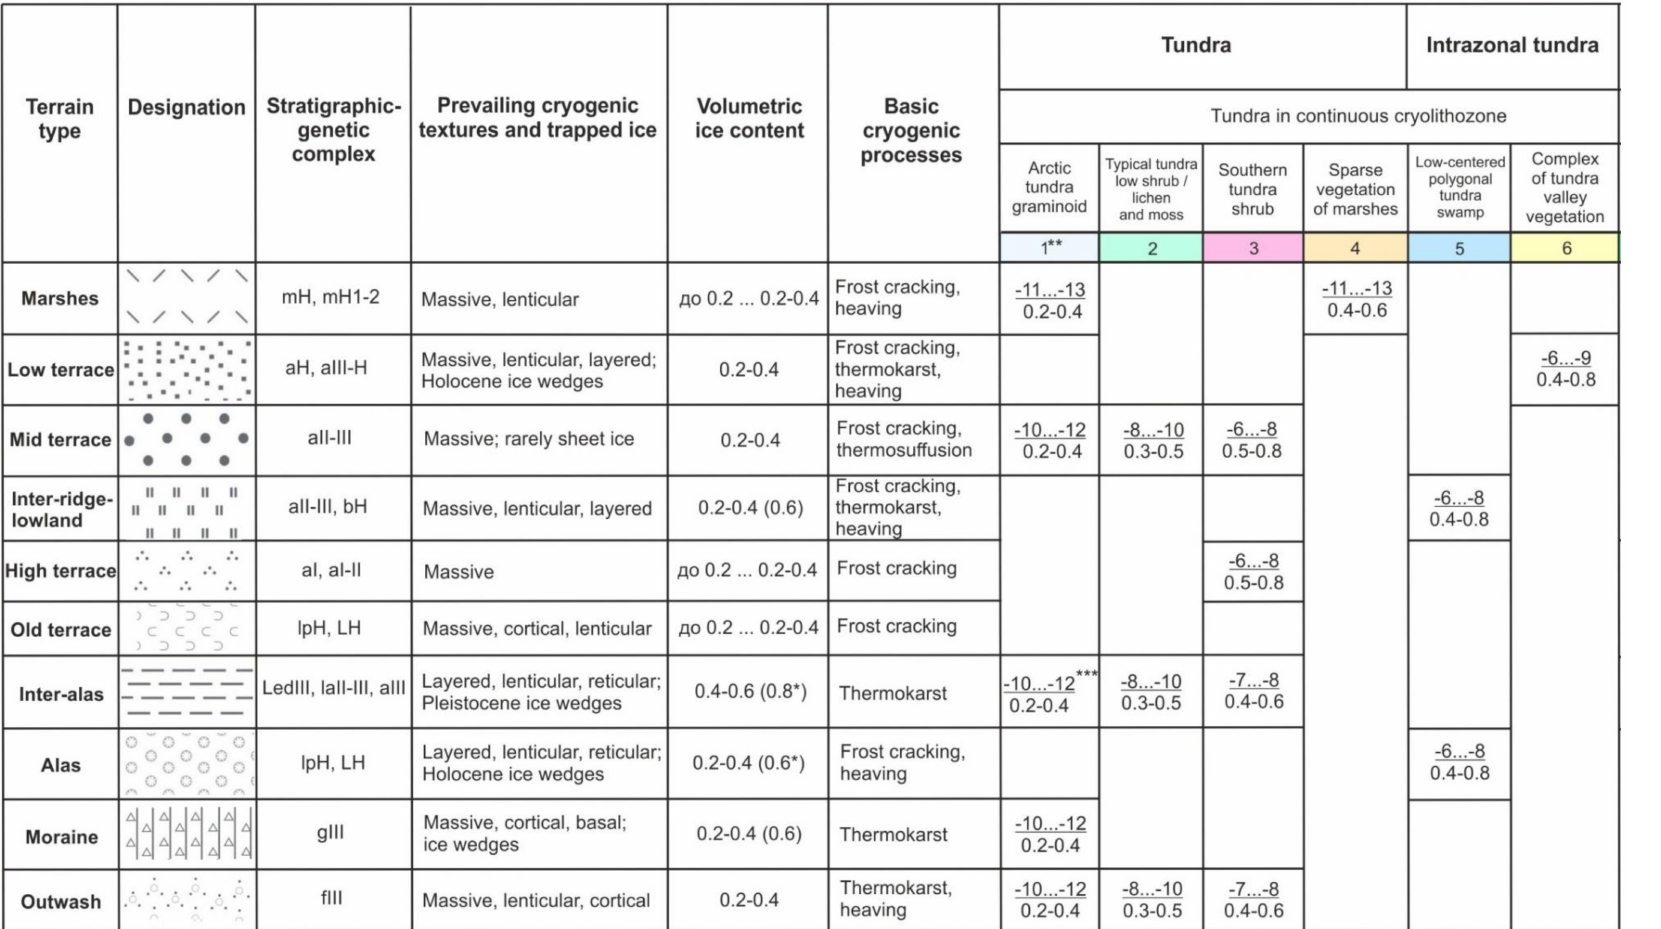
Figure 2. Fragment of legend of permafrost-landscape map of Sakha (Yakut) Republic in original